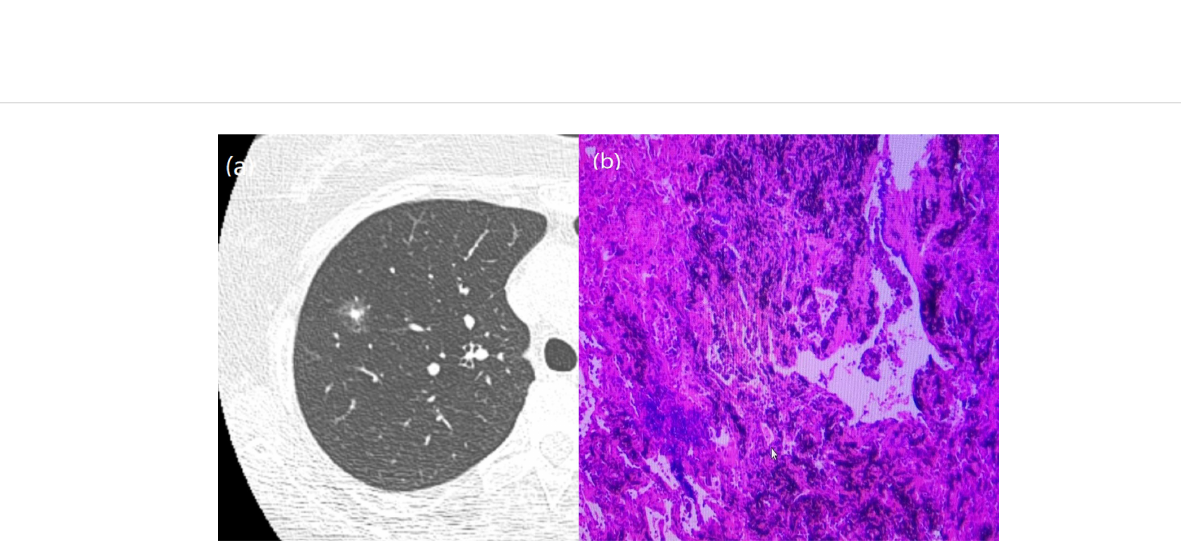
FIGURE 4 A 51-year-old man with a GGN. CT showed burr. (A) Chest scan. (B) pathologically con fi rmed for